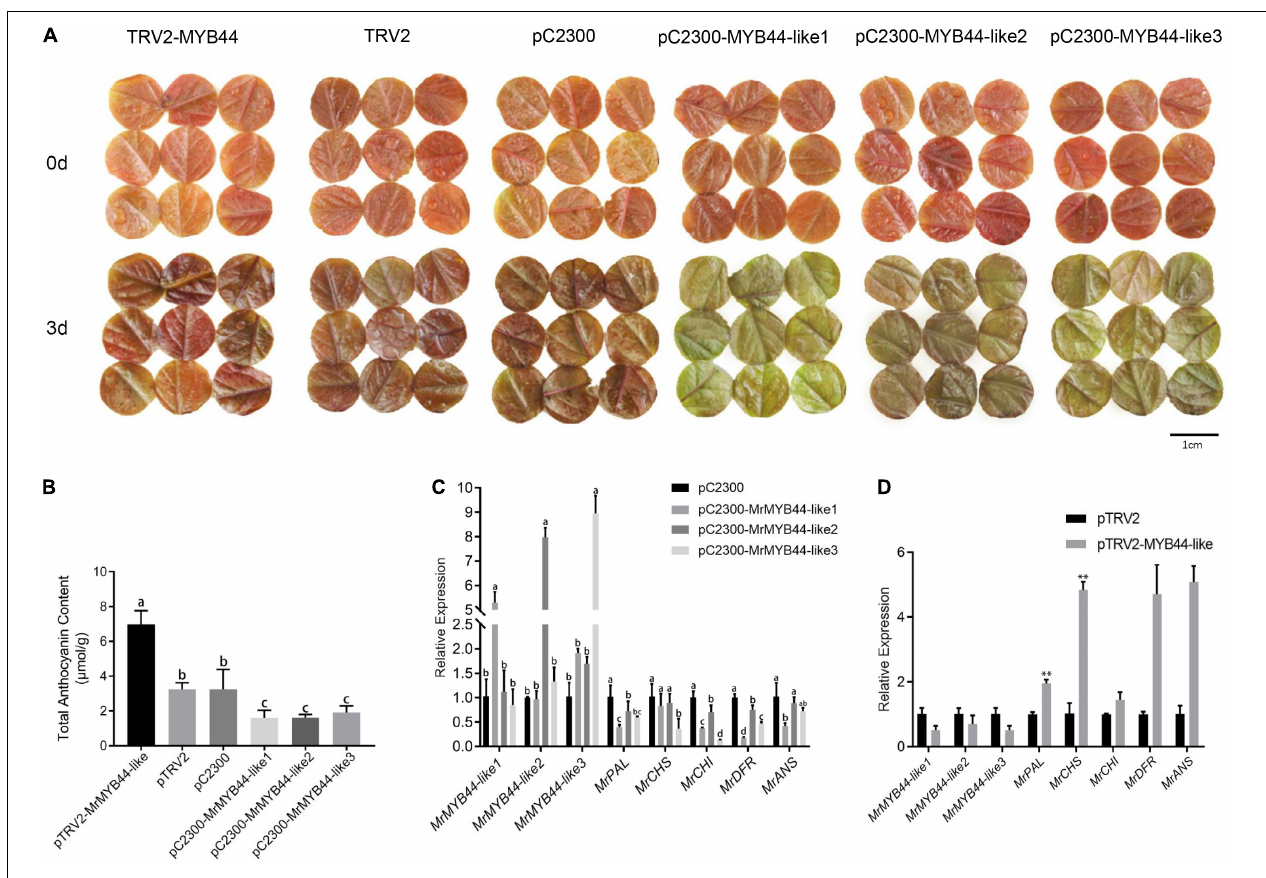
FIGURE 7 | Relative anthocyanin contents and transcript levels of genes in the anthocyanin biosynthesis pathway in MrMYB44-like -overpression/repression transgenic leaf disks and empty vector control leaf disks of Malus ‘Radiant.’ (A) The phenotype of transgenic and control disks. (B) Relative anthocyanin content of transgenic and control disks. (C) Transcript levels of MrMYB44-like s and structural genes related to anthocyanin biosynthesis in MrMYB44-like -overexpression and control leaf disks. Error bars represent the standard errors. Different lowercase letters indicate significant differences among treatments according to one-way ANOVA test ( P < 0.05). (D) Transcript levels of MrMYB44-like s and structural genes related to anthocyanin biosynthesis in MrMYB44-like -silenced and control leaf disks. Error bars represent the standard errors. ∗ P < 0.05, ∗∗ P < 0.01 using the t